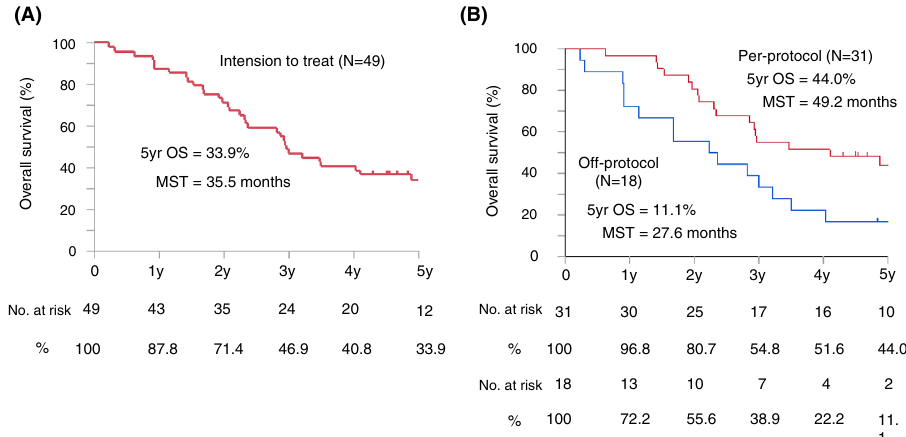
Figure 3. Kaplan–Meier survival curves for overall survival. ( A ) Intention to treat patients (n = 49). ( B ) Per- protocol patients (neoadjuvant treatment completion and tumor resection, n = 31) and off-protocol patients (neoadjuvant failure or probe laparotomy, n = 18). OS, overall survival; MST, median survival